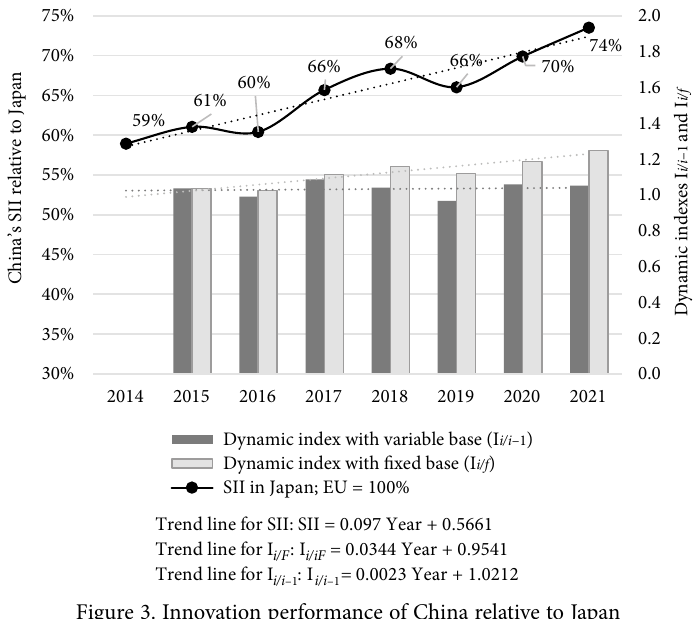
Figure 3. Innovation performance of China relative to Japan (source: author’s computations using data from the European Innovation Scoreboard